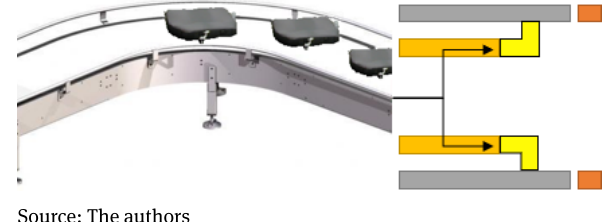
Figure 4: Design of a conveyor